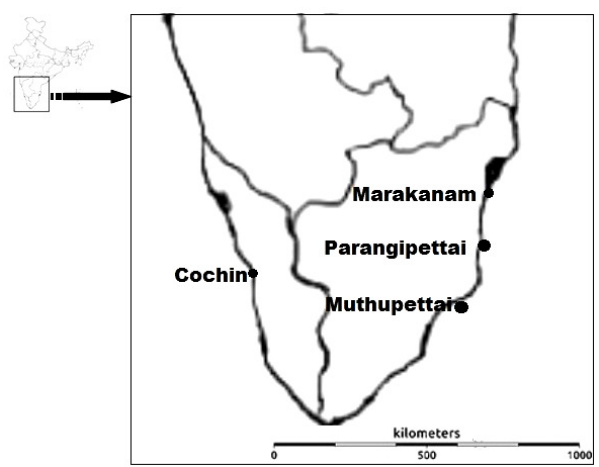
Fig. 1. Map showing the study